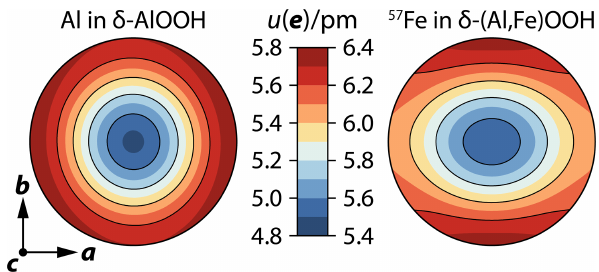
Figure 7. Root of the mean-square displacement u( e ) = (cid:112) e i e j U ij (RMSD) as a function of the displacement direction e for Al atoms in δ -AlOOH (left) and 57 Fe atoms in δ -(Al,Fe)OOH (right). Note the different scales for the RMSD for Al and 57 Fe atoms. The ori- entation of stereographic projections is indicated by the crystallo- graphic coordinate system at the bottom